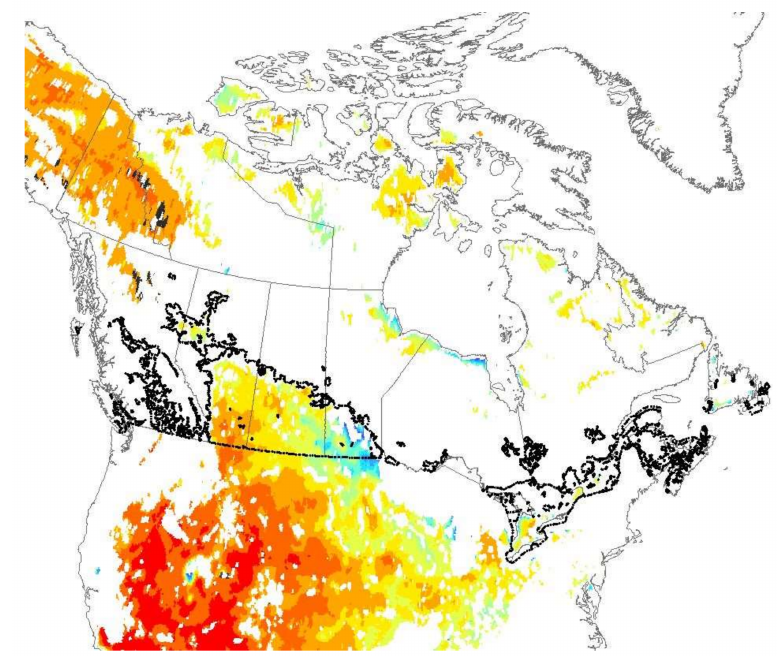
Figure 1. Study area. Thick dotted black line depicts ecological limits of where agriculture is conducted in Canada. The colored area of the map shows typical spatial extent of SMAP soil moisture retrievals during the active growing